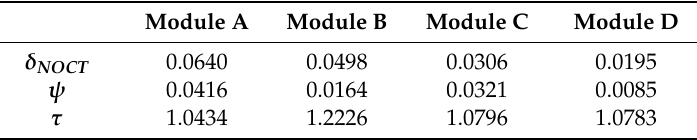
Table 4. Parameter values referring to methods